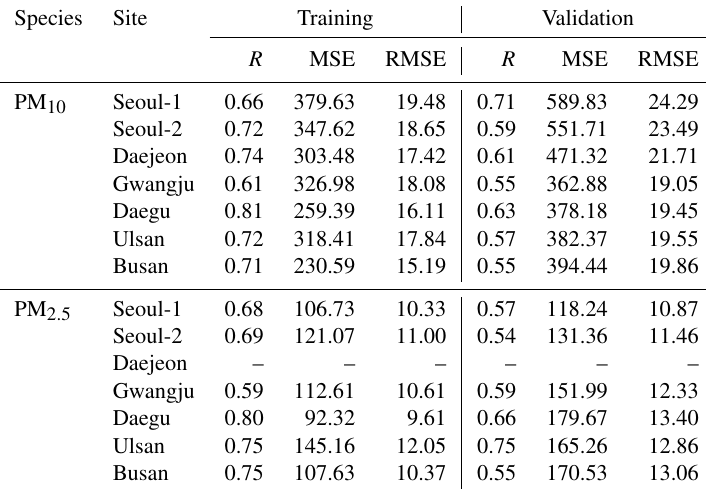
Table 1. Summary of model training and validation results. Species Site Training Validation R MSE RMSE MSE PM 10